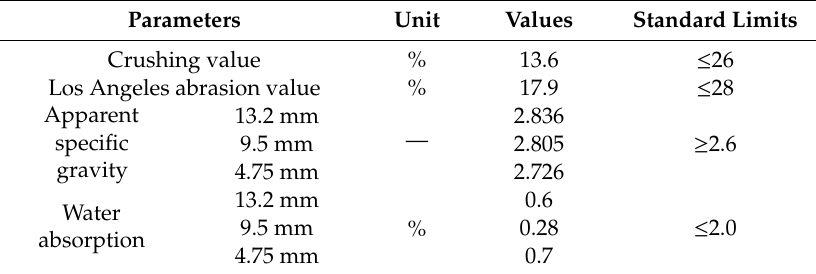
Table 2. Technical properties of coarse fine aggregate.